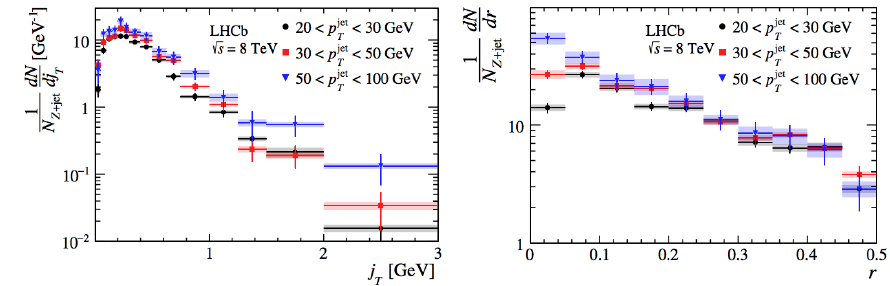
(cid:112) s = 8 TeV [ 8 ]